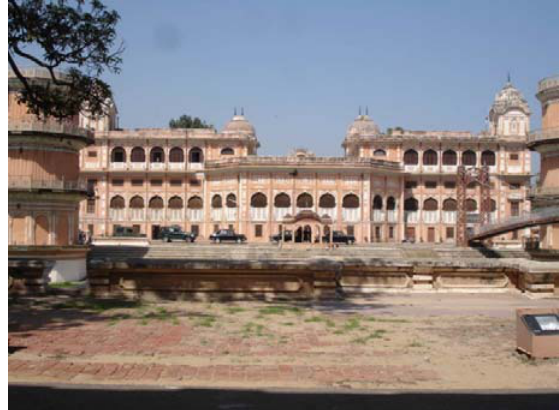
Figure 1: The Sheesh Mahal Exterior Front Facade